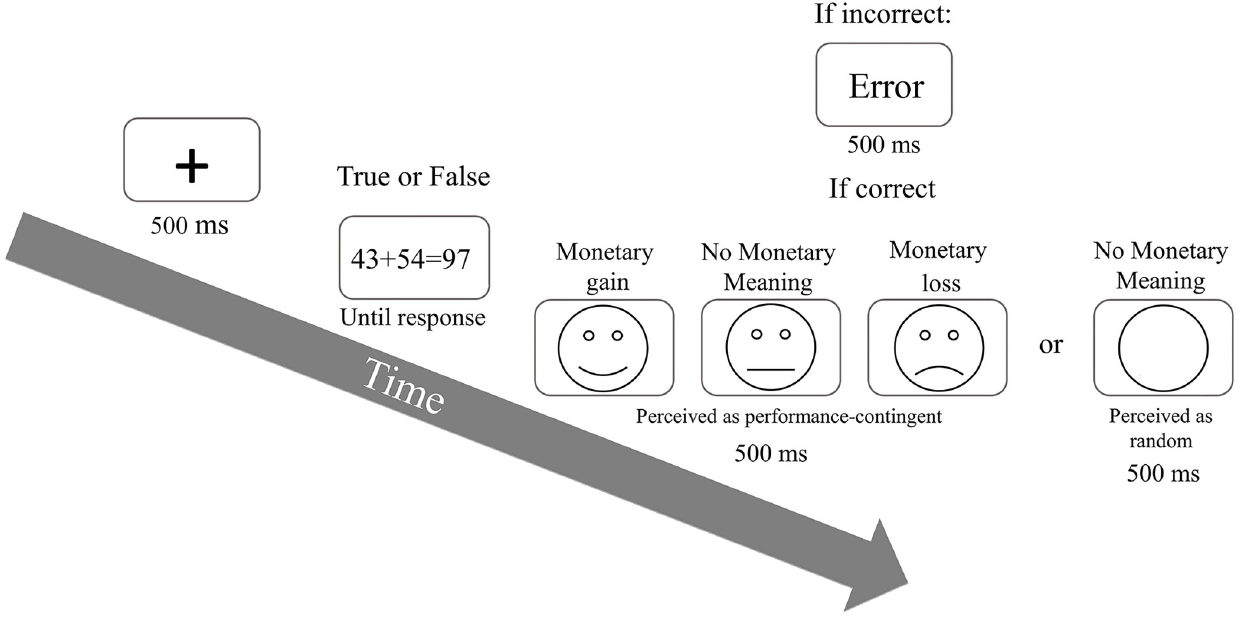
Fig 3. Experiment 2 trial procedure. Experiment 2 included a fourth gaining stimuli, comprised of an empty circle with no facial features. This stimulus appeared randomly after correct trials and had no monetary meaning (i.e., neutral non-feedback). again, here too performance after each gaining condition ( n+1 ) is